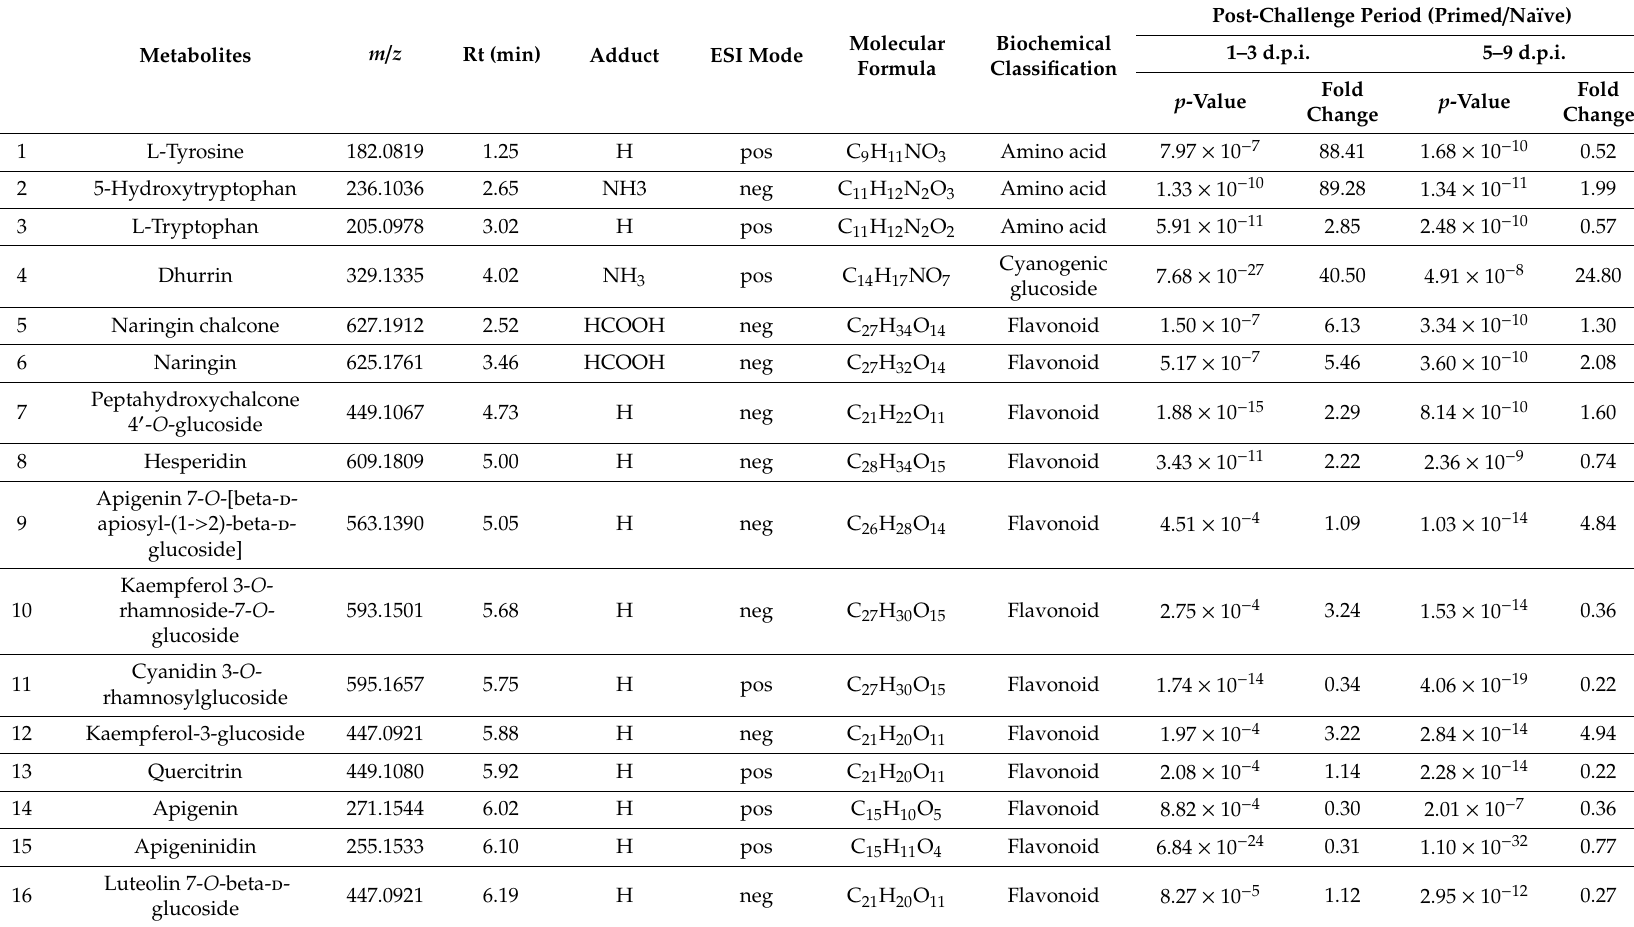
Table 1. Summary of annotated (MSI-level 2) metabolites that contributed to the discriminating variability in the altered metabolomes as described by chemometric models. These discriminating, putatively identified metabolites were identified based on OPLS-DA S-plots and SUS-plots, with a rigorous statistical validation. These reported metabolites had p -values < 0.05 and VIP scores > 1.0. Fragmentation data and applicable references are reported in Table